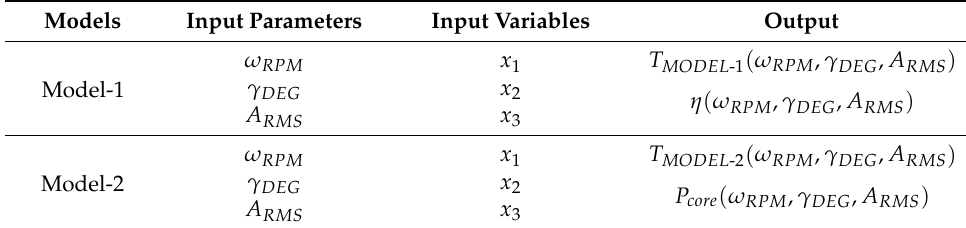
Figure 2. Efficiency and core loss map estimation models. The input and output parameters of Model-1 and Model-2 based on the multivariate polynomial regression general equation are expressed in Table 2 for clarity. The input variables of Model-1 and Model-2 are defined as Speed ( ω RPM ), Gamma ( γ DEG ) and Current ( A RMS ). The output variables of Model-1 are Torque ( T MODEL -1 ) and Efficiency ( η ) . The output variables of Model-2 are Torque ( T ( P ) . core MODEL -2 ) and CoreLoss Table 2. Input and output parameters for Model-1 and